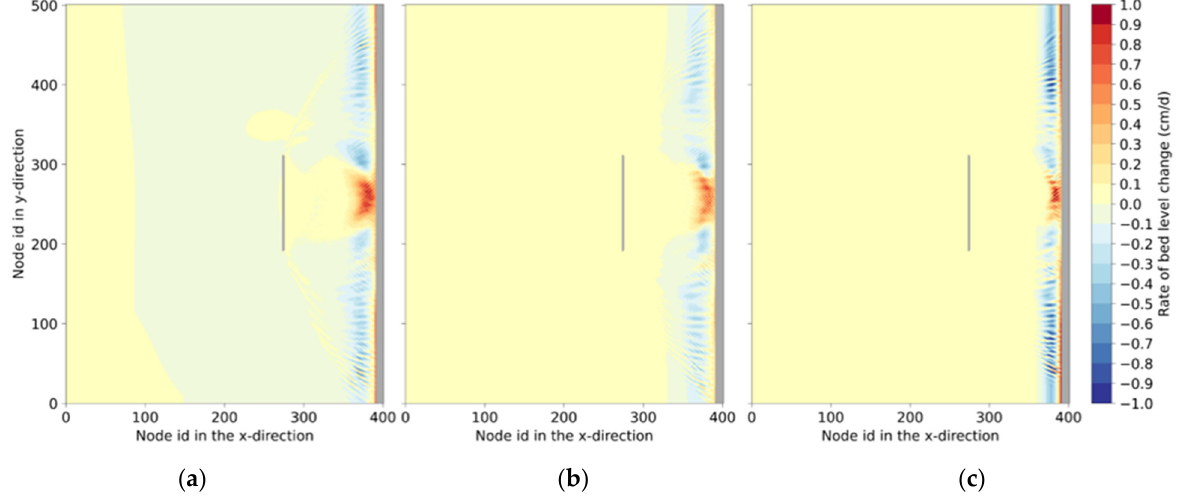
Figure 8. Integrated annual rate of bed level change for the: ( a ) “BF” ( b ) “EW w/ANN”, and ( c ) “EW” simulation sets.